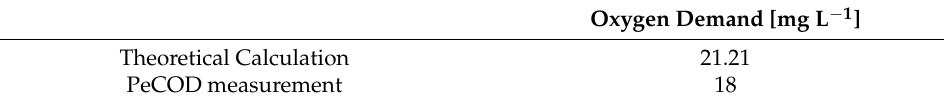
Table 4. Evaluation of synthetic NOM matrix ThOD to PeCOD measurement.